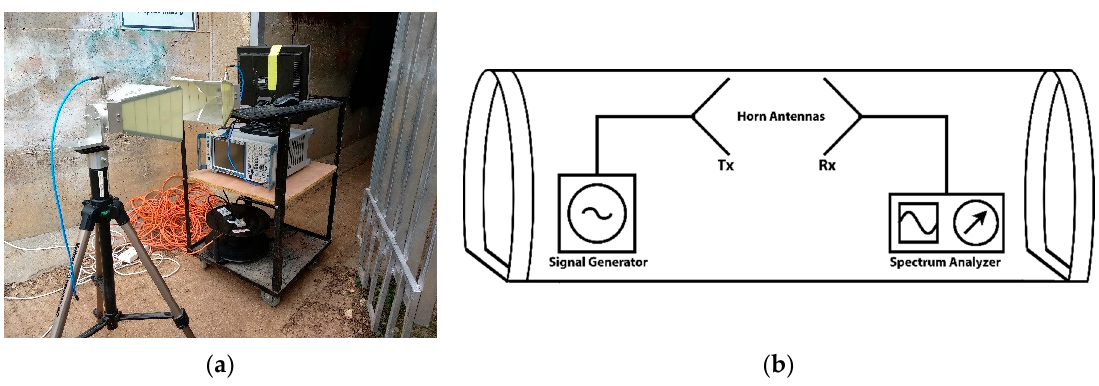
Figure 4. ( a ) Experimental setup in the tunnel, and ( b ) block diagram of experimental setup.